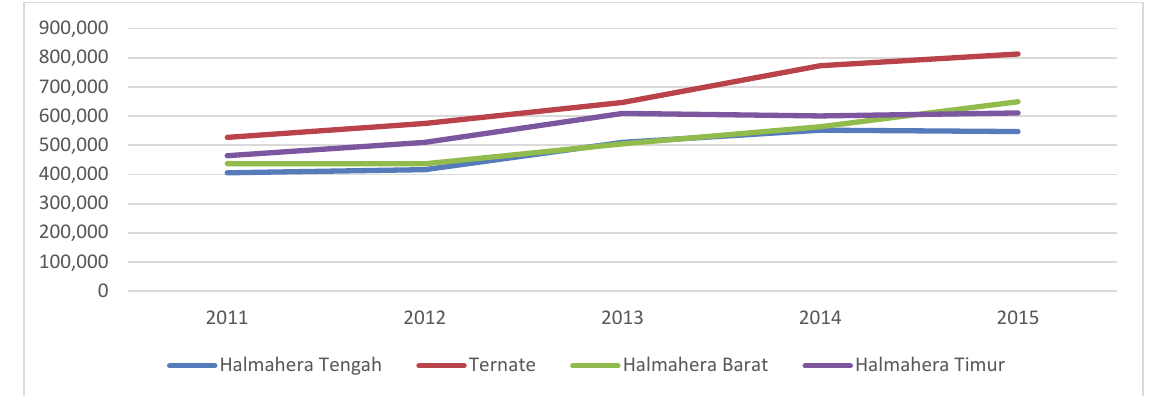
Fig. 1. Trend of Budget Increases in Selected